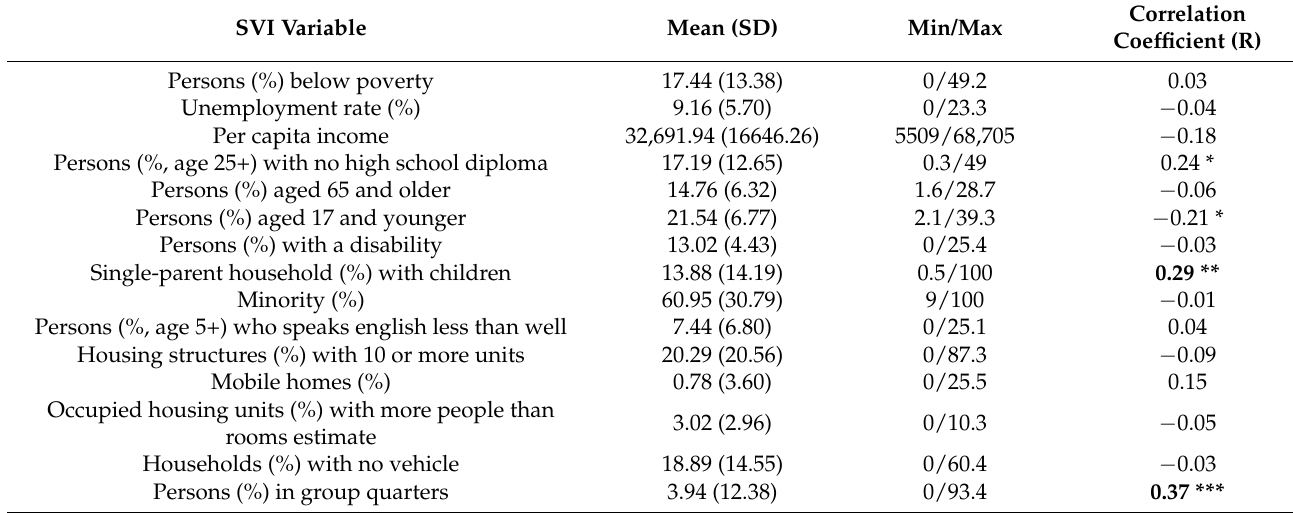
Table 1. Pearson’s correlation analysis between selected SVI variables and the RN index on the census tract level ( n =